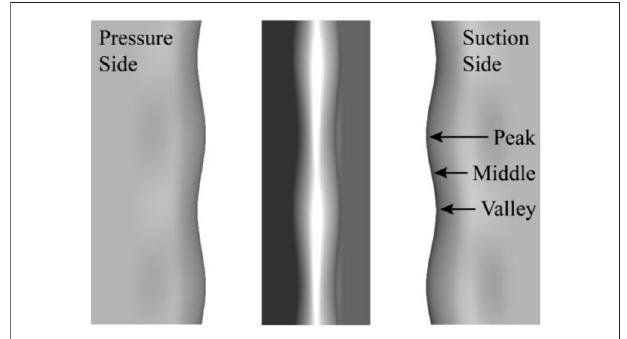
FIGURE 12 | Sections of peak, middle, and